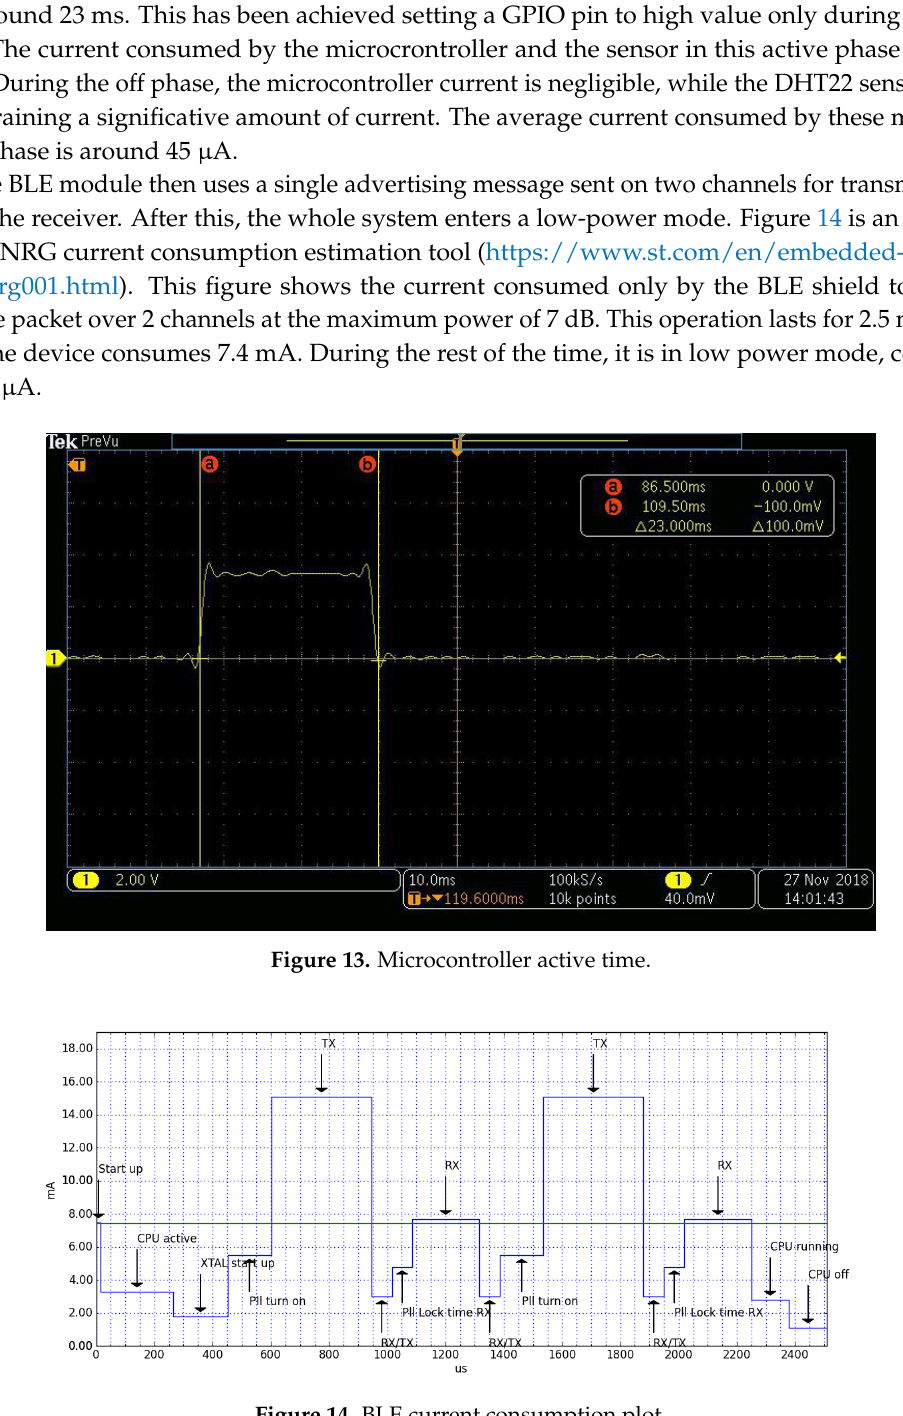
Figure 14. BLE current consumption